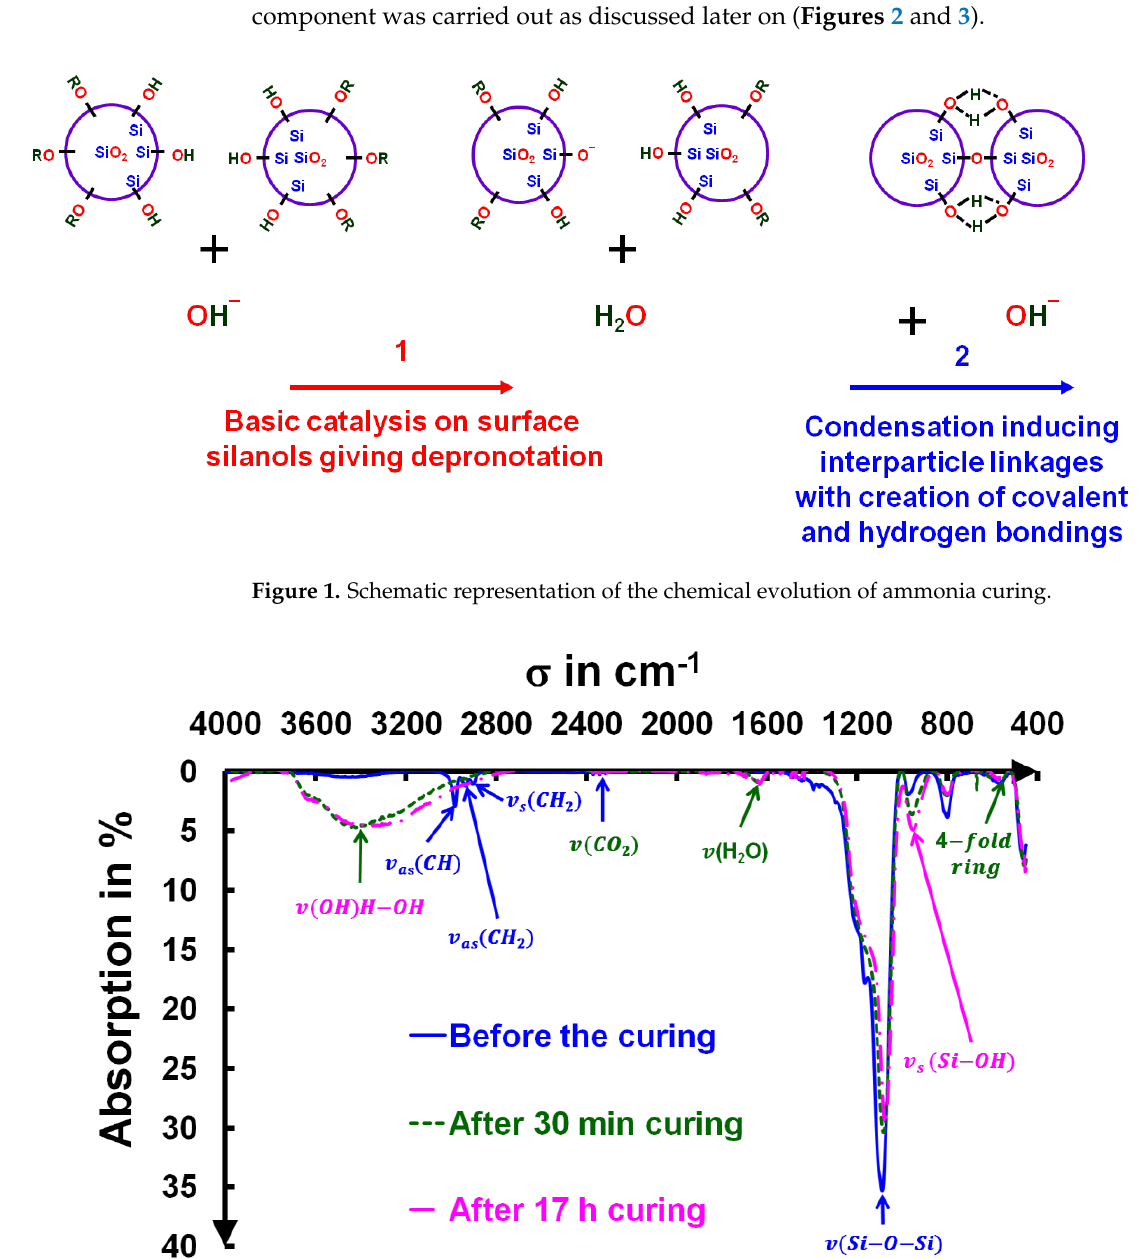
Figure 2. Evolution of IR spectra before and after different curing times (30 min and 17 h) for the same film.